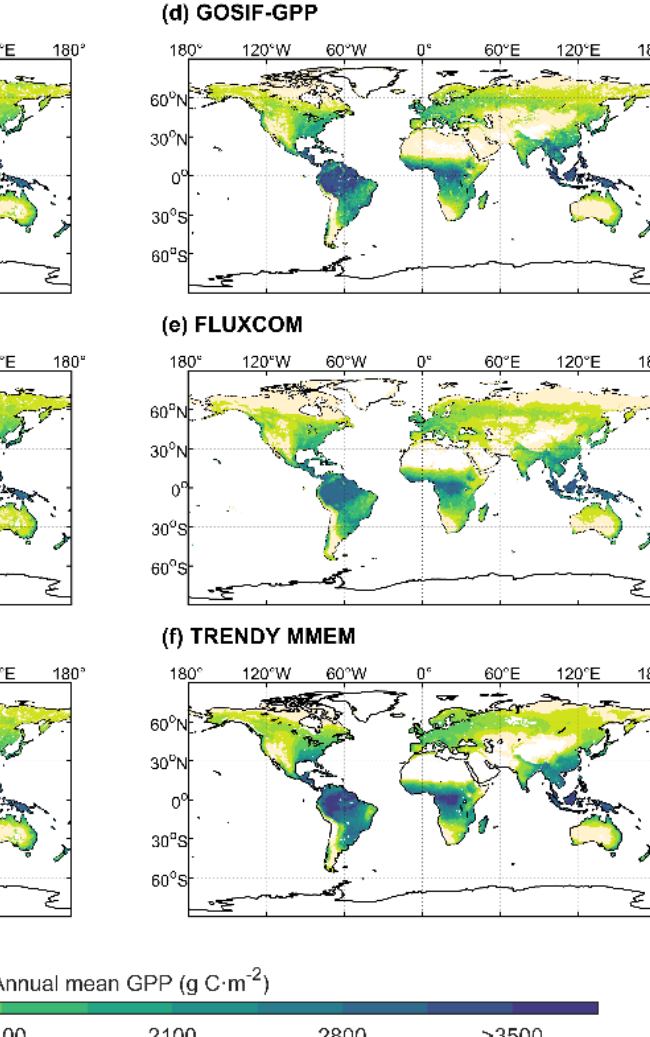
Figure 3. Spatial patterns of global annual mean GPP for 2003–2018. ( a – c ) represent GPP estimates based on each vegetation index with optimal configurations. ( d ) GOSIF-GPP; ( e ) FLUXCOM GPP. ( f ) represents the average of the multi-model ensemble mean.